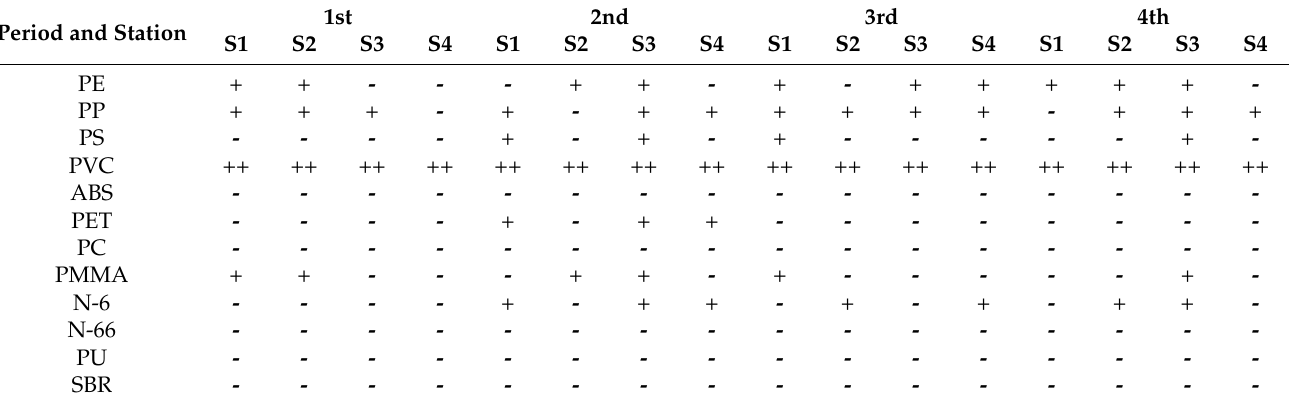
Table 3. Identification of polymer associated with microplastics found in polychaete samples during the sampling period and